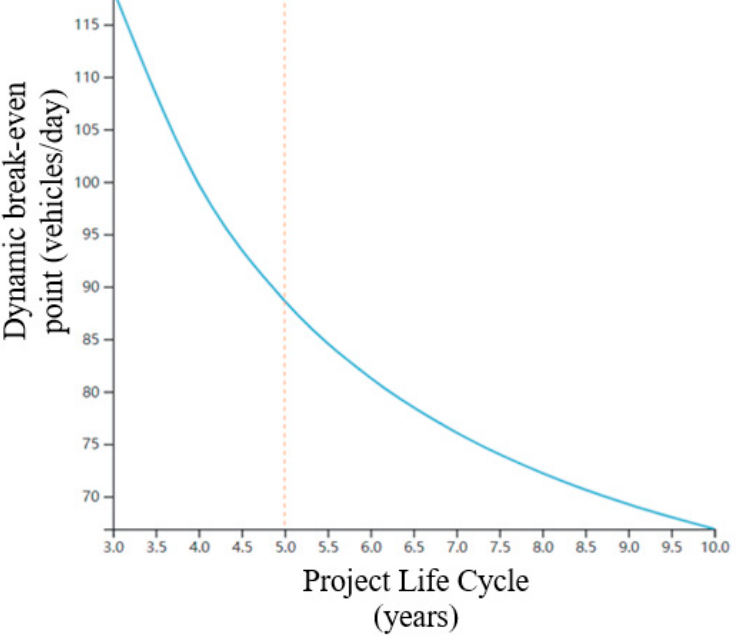
Figure 12. Sensitivity analysis of the project cycle.